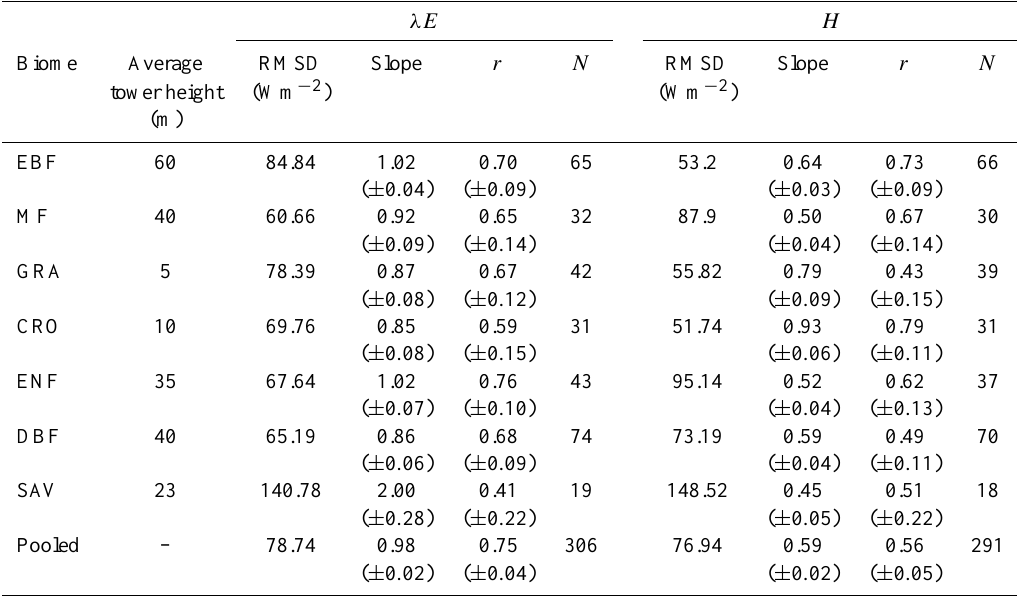
Table 3. Error analysis of AIRS-derived λE and H over diverse plant functional types (biomes) of the FLUXNET eddy covariance network. Values in the parenthesis are ± 1 standard deviation unless otherwise stated.